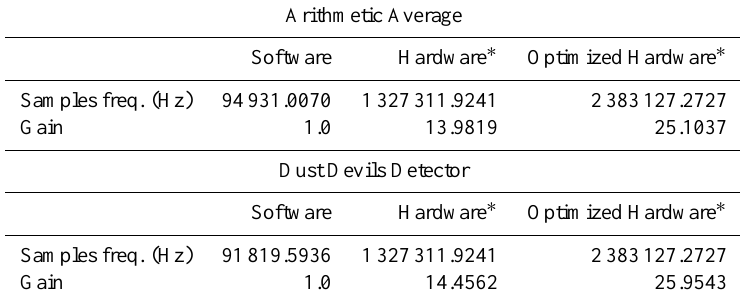
Table 2. Hardware and Software comparative.